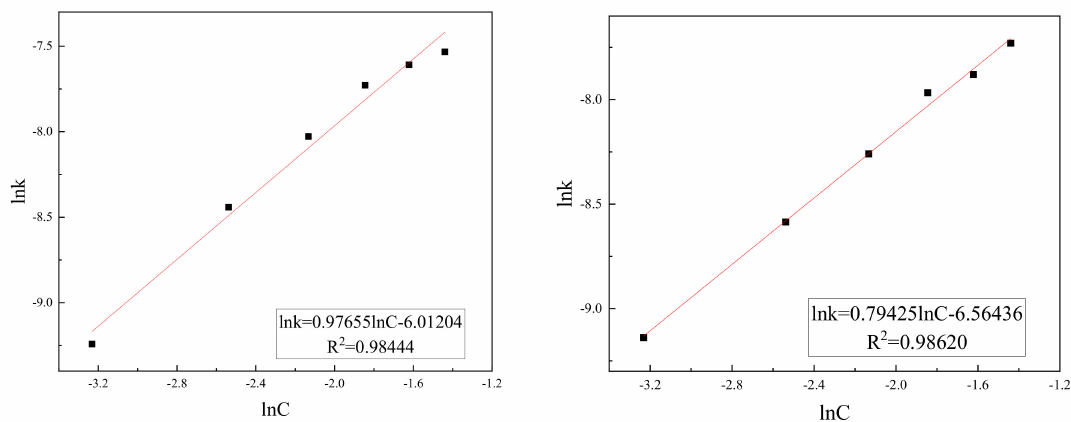
Figure 9. Relationship between ln k and ln C in the RE and Al leaching processes.